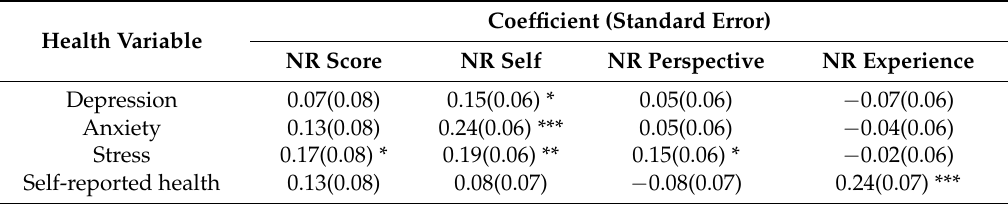
Table 3. Relationships between Nature Relatedness and Four Health Variables (From Ordinal Regression Models, Cumulative Link), Accounting for